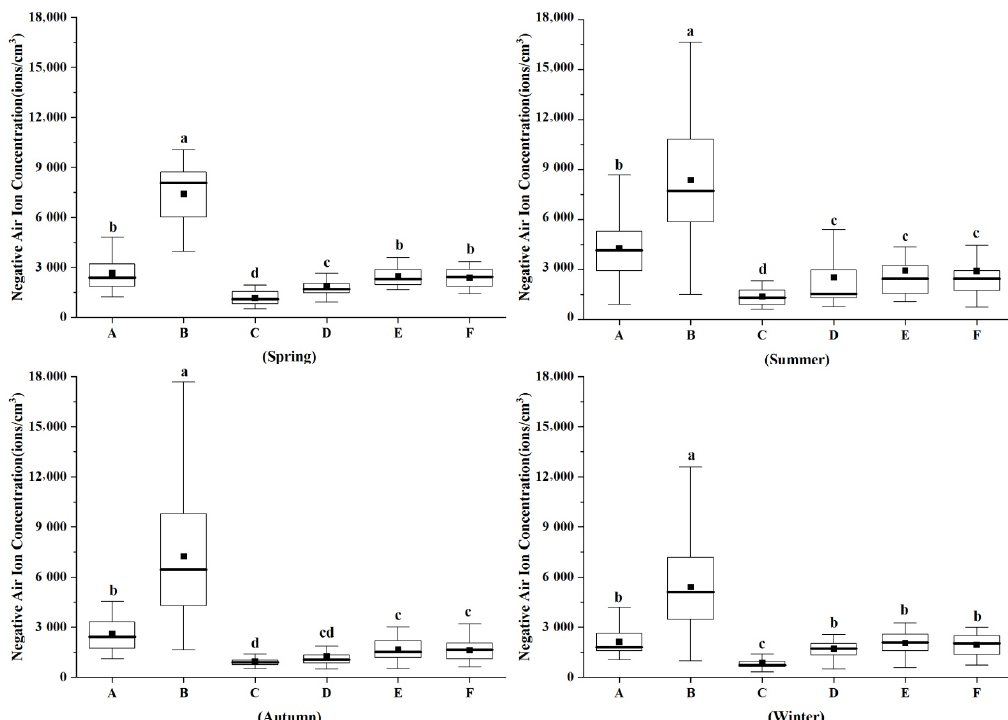
Figure 5. Comparison of negative air ion concentration in different forest types. A— Phyllostachys edulis forest; B—Subtropical evergreen broad-leaved forest; C—Forestless control group; D— Liquidambar formosana forest; E— Cunninghamia lanceolata forest; F—Coniferous and broad-leaved mixed forest. The different lowercase letters indicate significant difference among the stand types in the same time ( P ＜ 0.05).